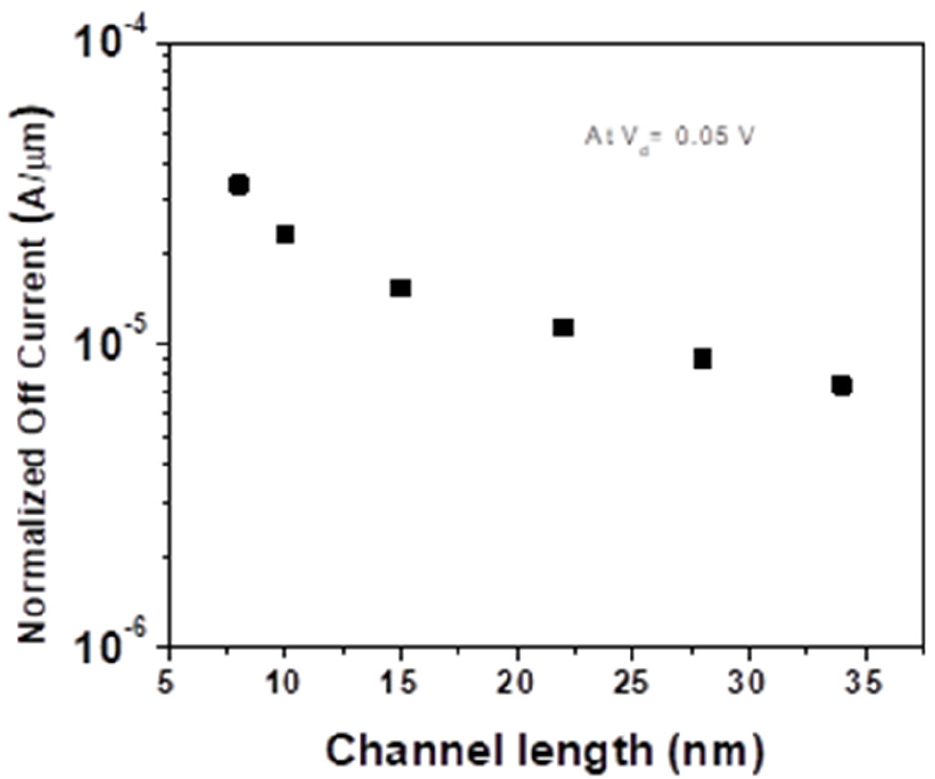
Figure 5. Normalized off-current (in A/ µ m) vs. channel length (in nm). This plot shows that off-current increases with a decrease in channel length as a result of poor gate control.